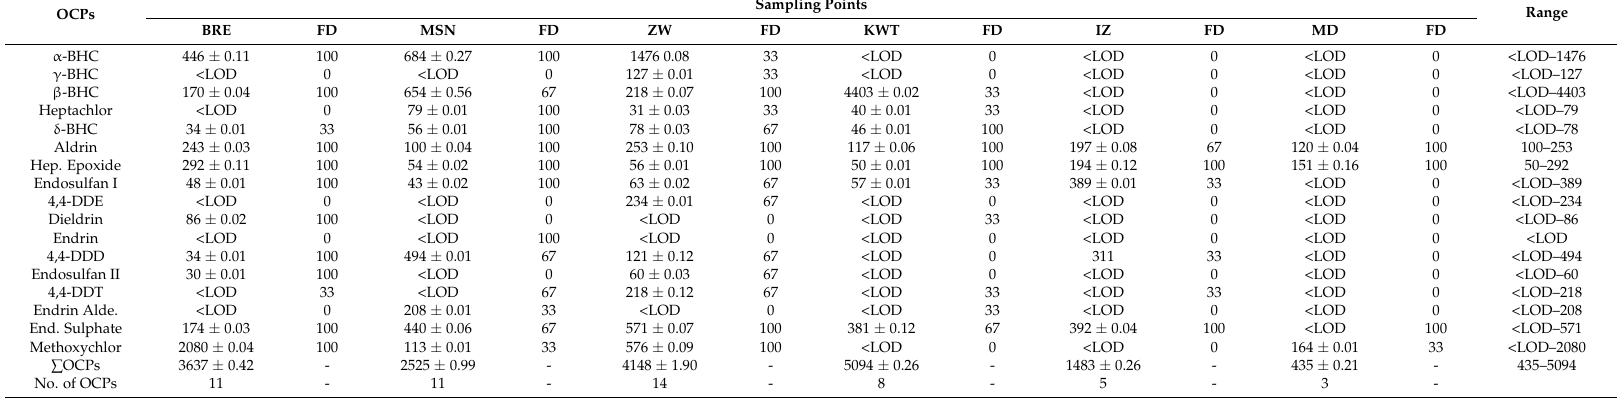
Table 3. Total mean concentrations (ng/L) of OCPs in summer in surface water along the course of the Buffalo River (Values are means ± SD; N = 3).